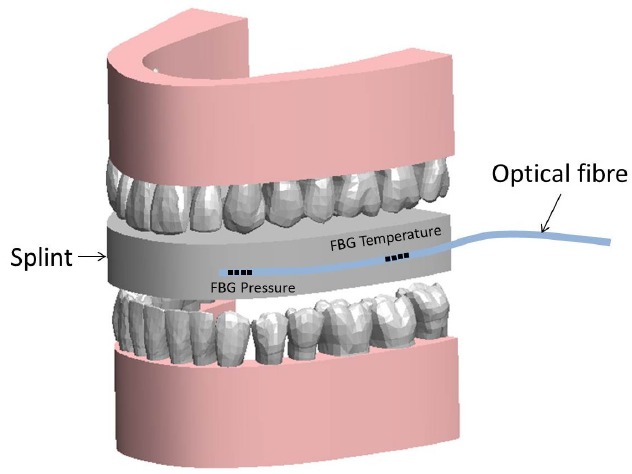
Figure 6. Schematic representation of a dental splint with embedded fiber optic sensors, to monitor force and temperature (adapted from